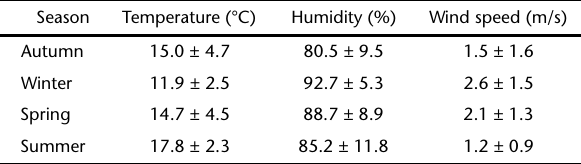
Figure 10. Total number of bat passes recorded with a bat detector in each season for the five habitat types, from April 2009 to March 2010, in the grasslands of southernmost Brazil. Different letters indicate significant differences at the 0.008 probability level (with Bonferroni correction). Table II. Average values and standard deviation of the climatic factors measured in the transects monitored for bat activity, from April 2009 to March 2010, in the grasslands of southernmost